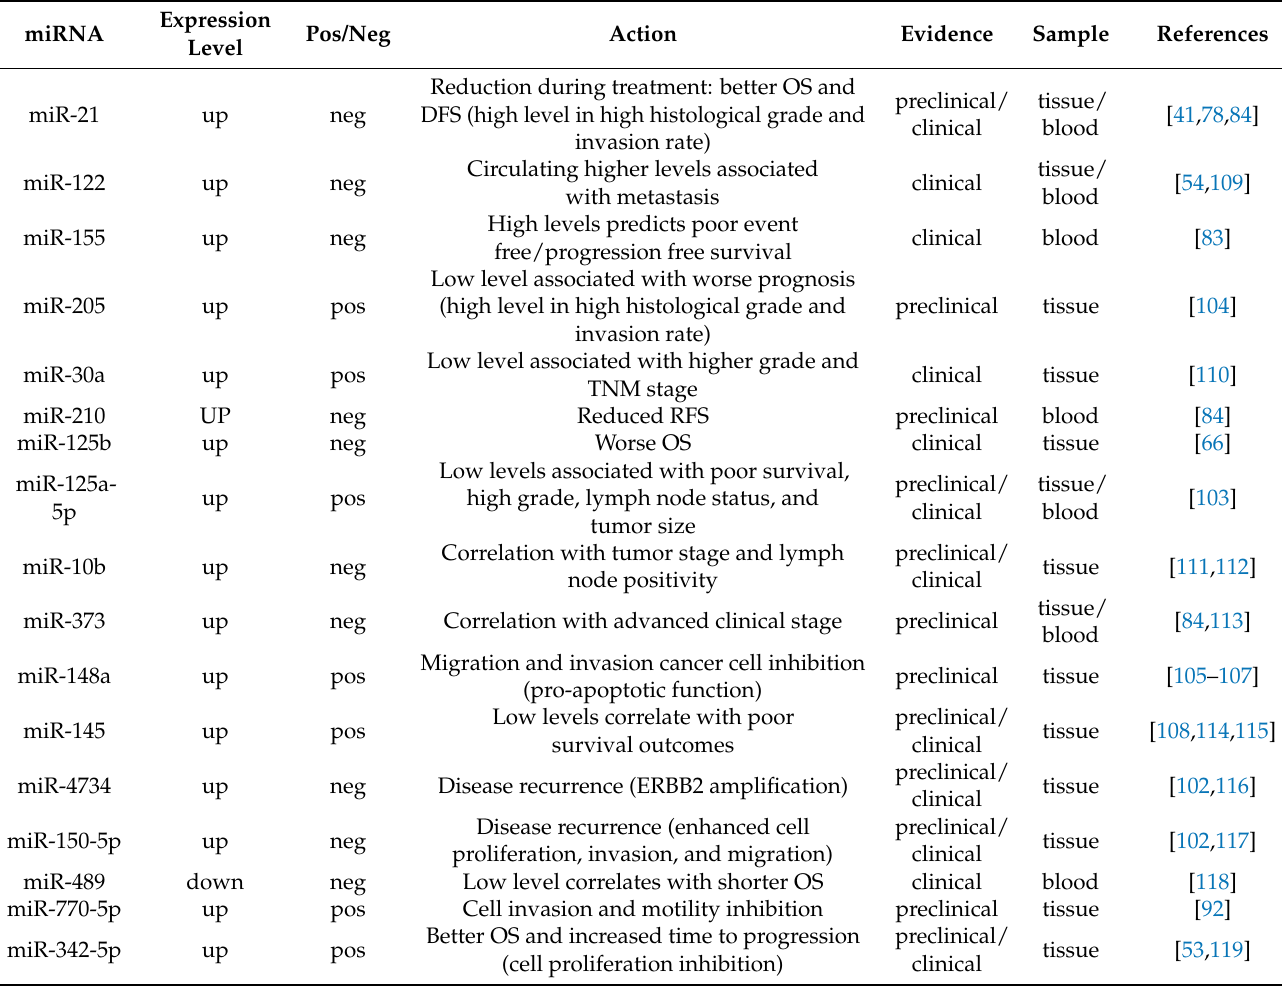
Table 3. Prognostic value of miRNAs expressed in HER2-positive early breast